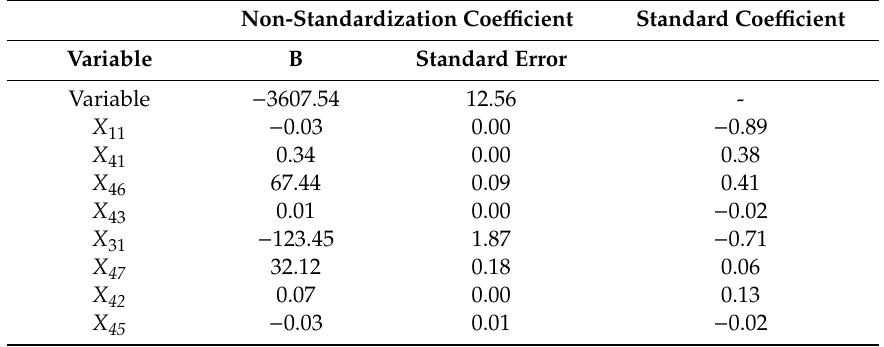
Table 7. Principal Component Analysis of Influencing Factors of Soil Organic Carbon